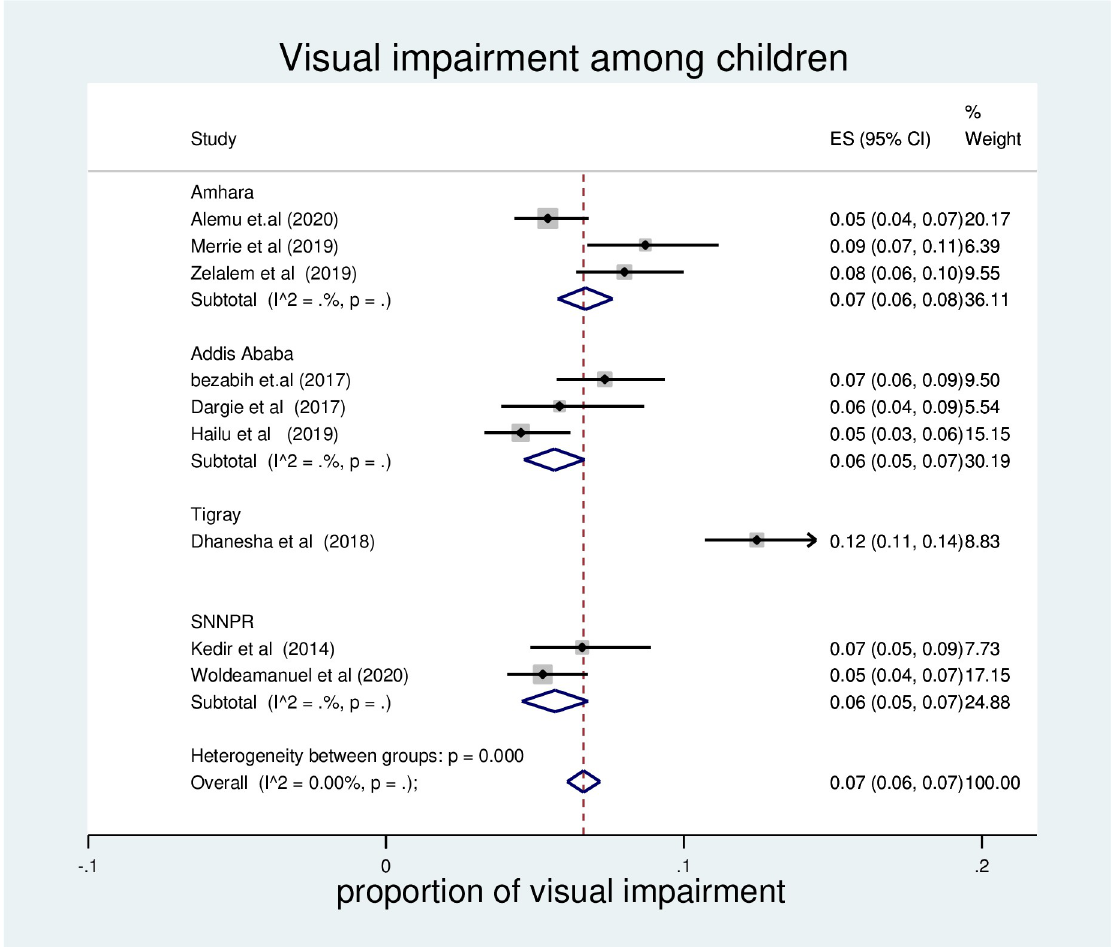
Fig 3. Forest plot of pooled visual impairment among children in Ethiopia by region,